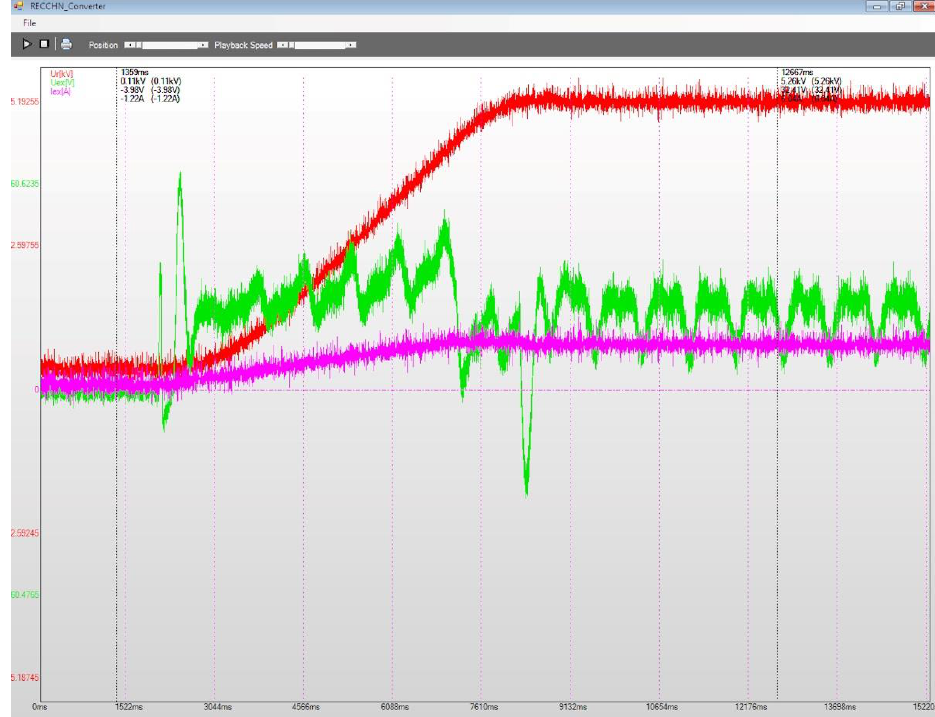
Figure 14. 5%, 10% debited power step commands, CHE Dăești, Vâlcea.